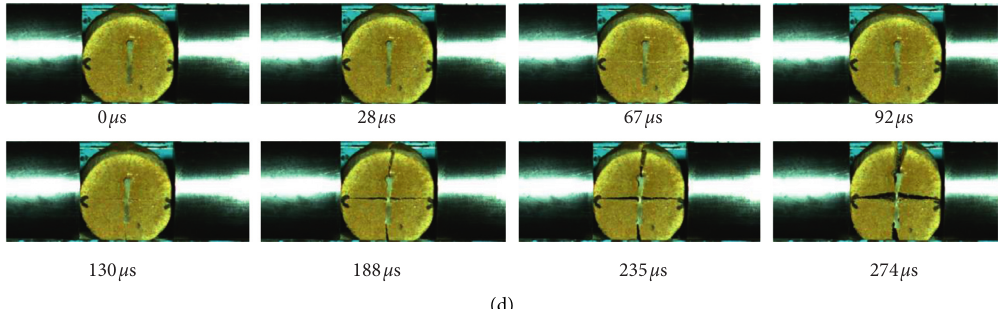
Figure 6: Failure process of samples with different fissure angles recorded by the high-speed photography at − 5 ° C. (a) T � − 5 ° C, θ � 0 ° . (b) T �− 5 ° C, θ � 30 ° . (c) T �− 5 ° C, θ � 60 ° . (d) T � − 5 ° C, θ � 90 °